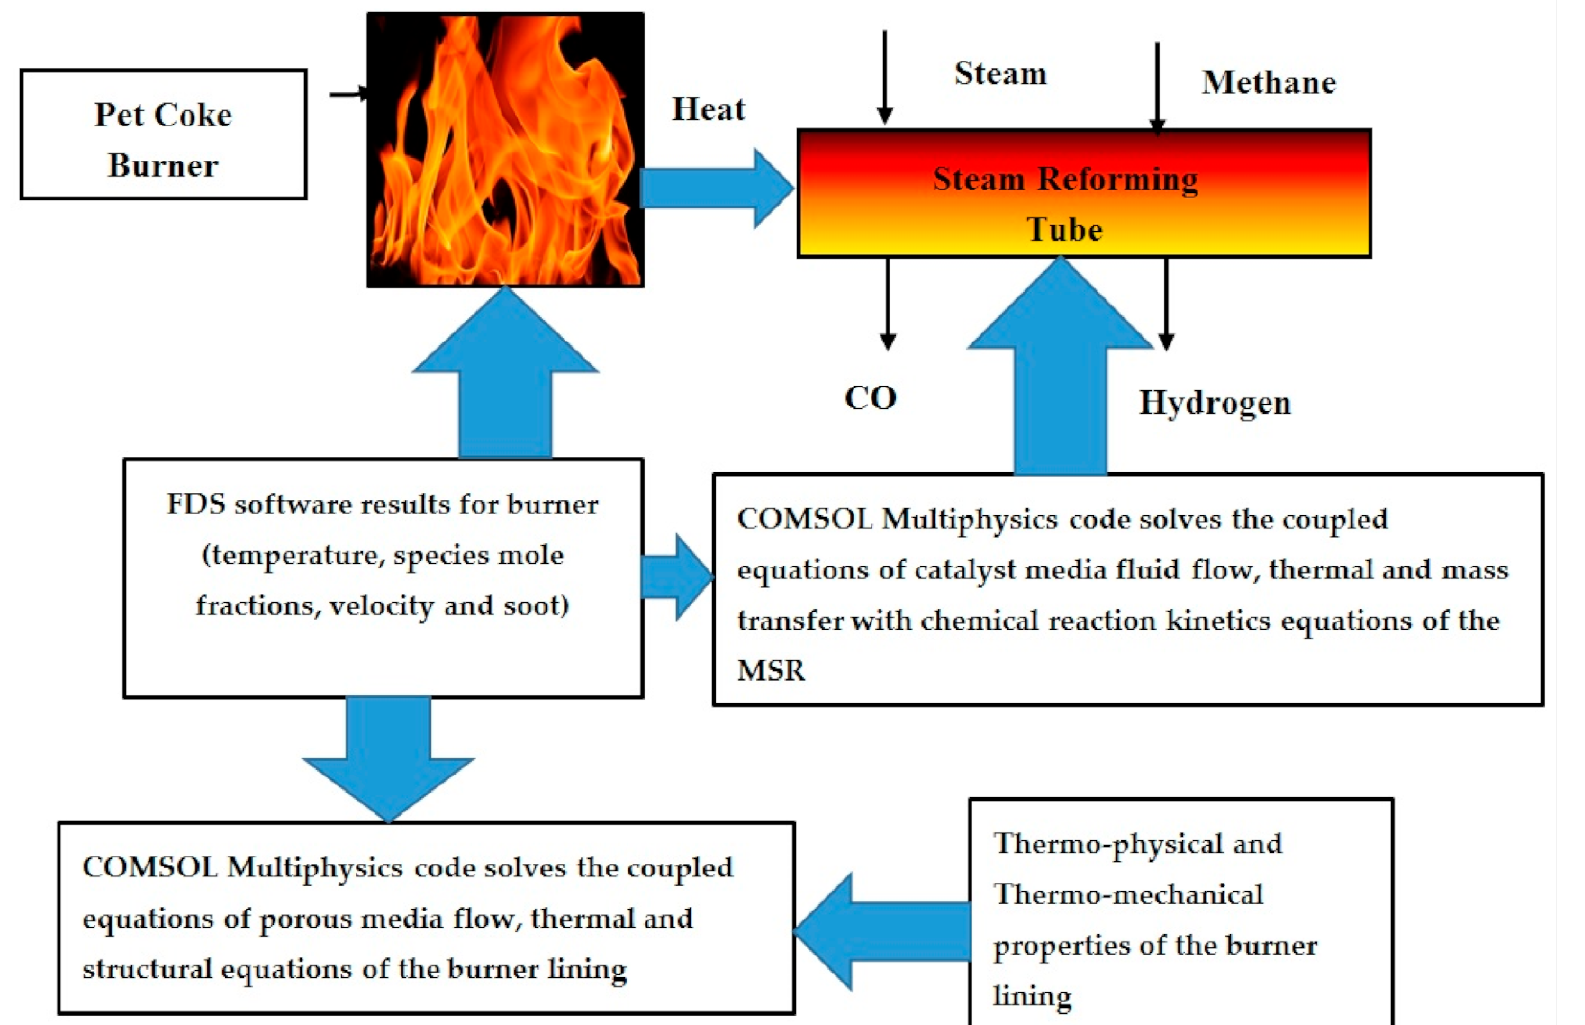
Figure 1. Schematics of methane steam reforming (MSR) system based on pet-coke